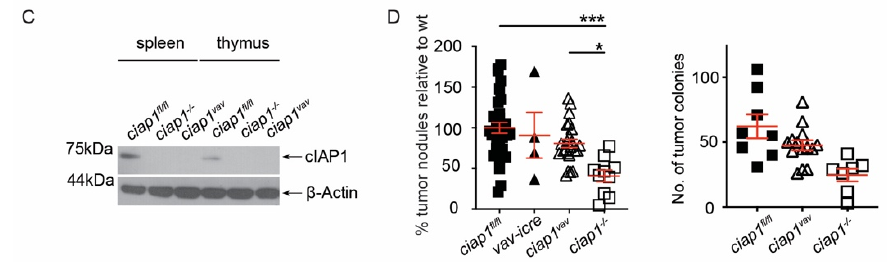
Figure 3. Loss of cIAP1 in the hematopoietic compartment does not alter the lung tumor load. ( A ) Represen- tative FACS plots of lung immune cell infiltrates following B16-F10 tumor challenge by flow cytometry. Inflam- matory monocytes (CD11b high MHCII - SiglecF - Ly6G - CD64 lo Ly6C high , identified by blue gate), patrolling monocytes (CD11b high MHCII - SiglecF - Ly6G - CD64 lo Ly6C low , identified by red gate), neutrophils (CD11b + Ly6G + , identified by green gate) and natural killer (NK) cells (CD3 - NK1.1 + , identified by black gate) were pre-gated on singlets, live and CD45 + cells (6 mice/group, performed twice). ( B ) Analysis of lung immune cell infiltrates following B16-F10 tumor challenge by flow cytometry shown in absolute numbers. ( C ) Splenocytes and thymocytes from ciap1 vav mice were analyzed by Western blotting to evaluate the levels of cIAP1. Representative immunoblot is shown. ( D ) ciap1 vav were challenged with B16-F10 tumor cells (i.v.) and nodules in the lung were counted 13 days later. Percentage of superficial B16-F10 tumor nodules in ciap1 − / − , ciap1 vav , Vav-icre and ciap1 fl/fl normalized to the average number of tumor nodules identified in the Wt ( ciap1 fl/fl ) in each independent experiment. A representative experiment showing primary tumor nodules is also shown. Each data point represents a mouse. Data are presented as mean ± SEM. * p < 0.05; ** p < 0.01; *** p < 0.001, two way ANOVA with multiple comparison test ( B ), one way ANOVA with Bonferroni’s test ( D